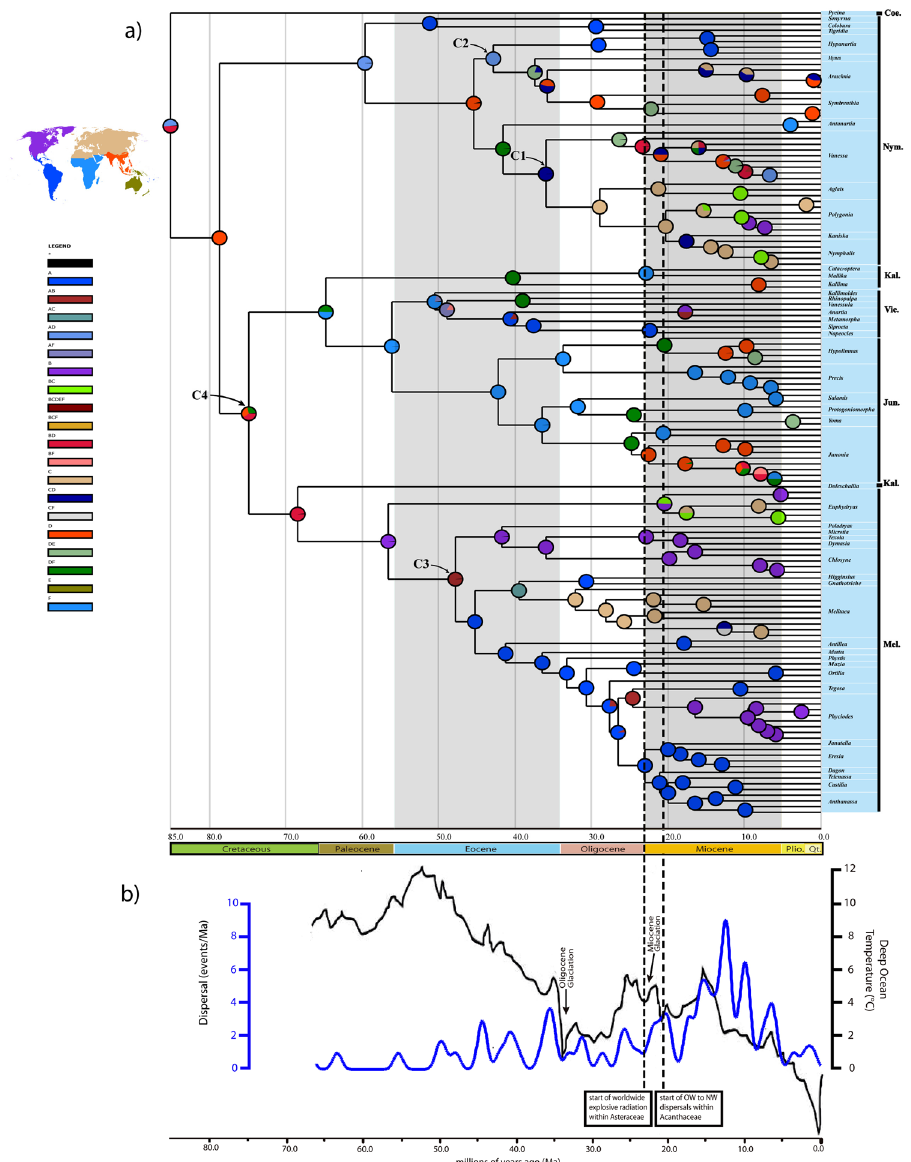
Figure 2. ( a ) Estimated time tree of the Nymphalinae (under Calibration Plan 1 A) with the results of the ancestral area reconstruction from S-DIVA analysis; C1, C2, C3, and C4 show the time calibration points (see under Methods); the map of biogeographic realms freely from https://commons.wikimedia.org/wiki/ File:Ecozones.svg, following the same license terms (https://creativecommons.org/licenses/by-sa/4.0/ legalcode). Coe., Coeini; Nym., Nymphalini; Kal., Kallimini; Vic., Victorinini; Jun., Junoniini; Mel., Melitaeini; Biogeographical realms: A, Neotropical; B, Nearctic; C, Palaearctic; D, Oriental; E, Australasian; F, Afrotropical; ( b ) Climatic-dispersal curve for Nymphalinae derived from S-DIVA analysis. Reconstruction of deep ocean temperatures (black curve, as a proxy for global temperature) is derived from oxygen isotopes corrected for variation in global ice volume (from Working Group I, 2007 Intergovernmental Panel for Climate Change report; see Fig. 6.1 therein); the time-events curve (blue curve) shows the changes in frequency of dispersal. OW, Old World; NW, New